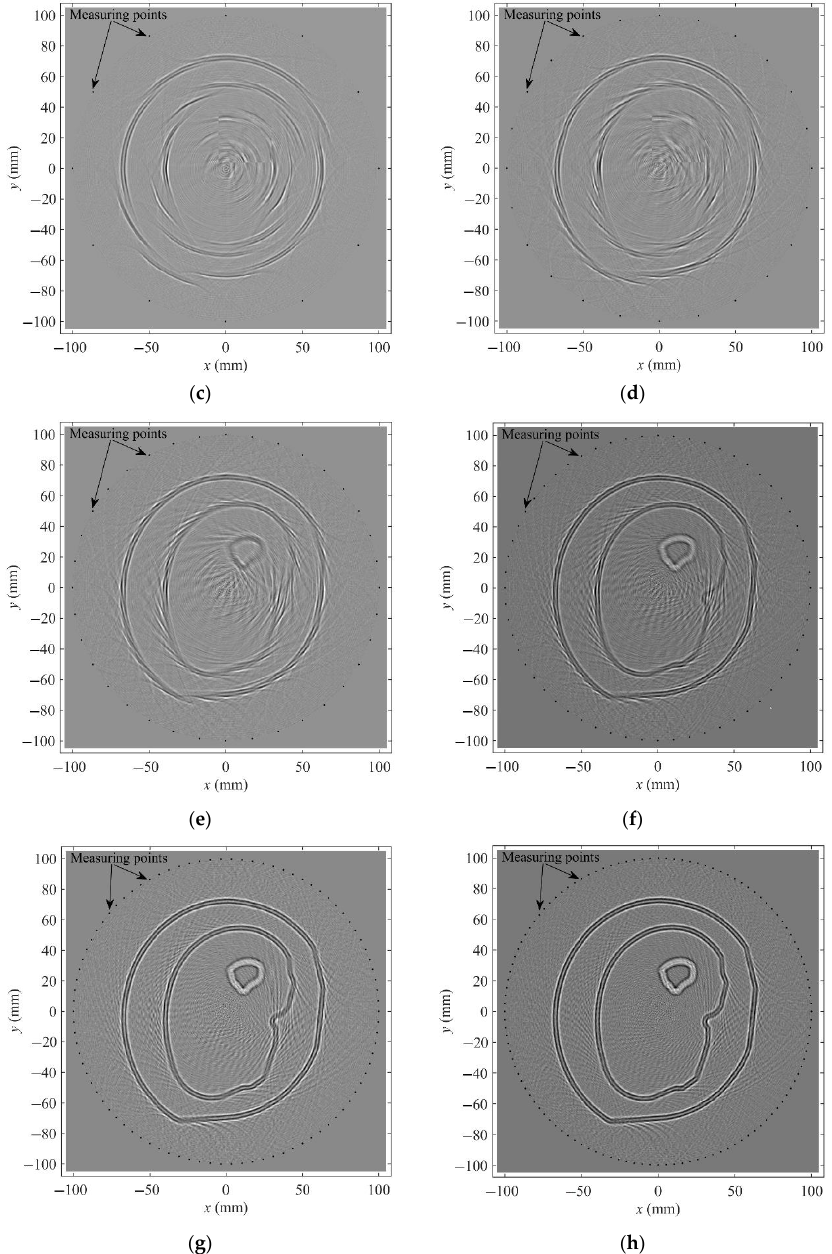
Figure 8. ( a ) Axial MRI image of the human thigh [29]; ( b ) the three-layer object to be imaged with Figure 8. ( a )AxialMRIimageofthehumanthigh[29];( b )thethree-layerobjecttobeimagedwithconductivities conductivities σ a , σ b , and σ c and the surrounding region σ 0 (distilled water equivalent); reconstructing σ σ σ σ a , c and the surrounding region b , and 0 (distilled water equivalent); reconstructing the acoustic the acoustic source position for: ( c ) 12 measuring points; ( d ) 24 measuring points; ( e ) 36 measuring sourcepositionfor: ( c )12measuringpoints; ( d )24measuringpoints; ( e )36measuringpoints; ( f )60measuring points; ( f ) 60 measuring points, ( g ) 90 measuring points; and ( h ) 120 measuring points. points, ( g ) 90 measuring points; and ( h ) 120 measuring